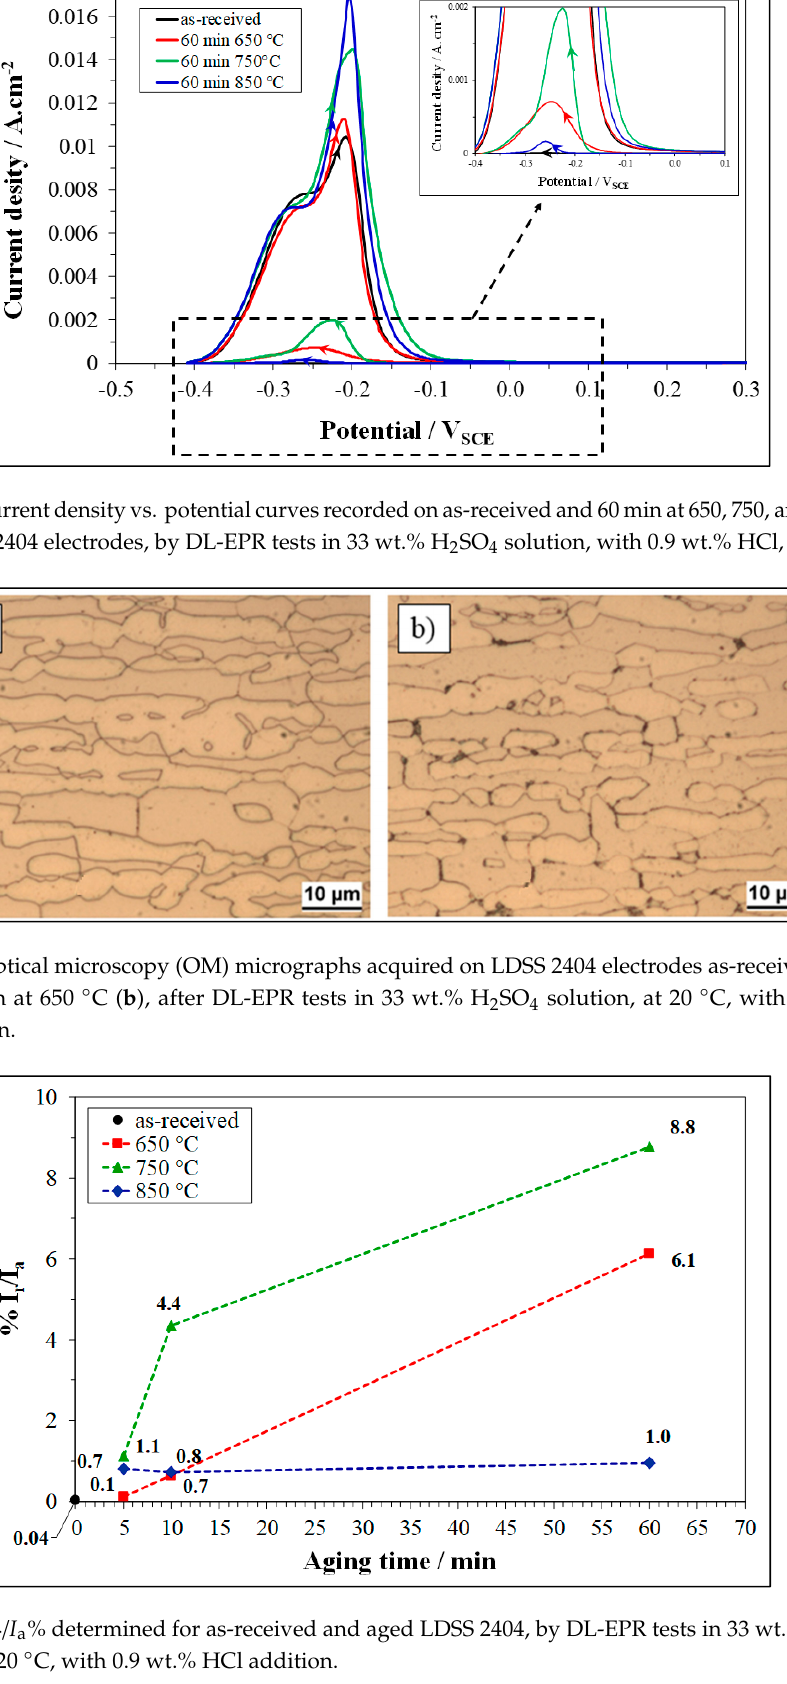
Figure 10 . I r / I a % determined for as-received and aged LDSS 2404, by DL-EPR tests in 33 wt.% H 2 SO 4 solution, at 20 °C, with 0.9 wt.% HCl addition.